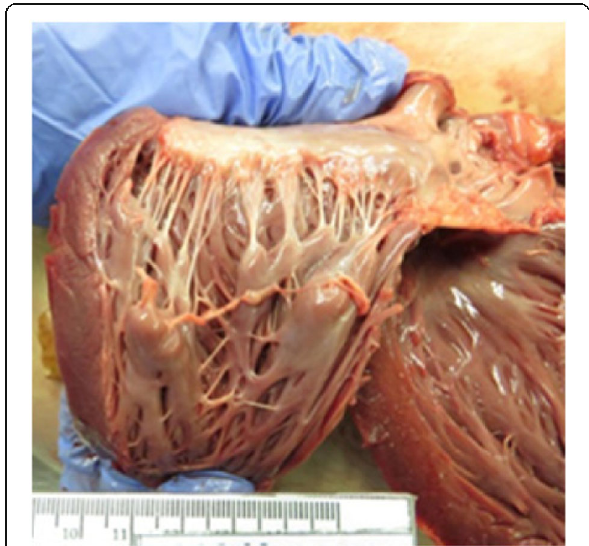
Fig. 3 Multiple apical and median anomalous chords, exhibiting basal fibrotic parietal endocardium, hypertrophy and shortening of trabecular muscles with haemorrhages from a young patient presenting with signs of CTD (connective tissue disorder)